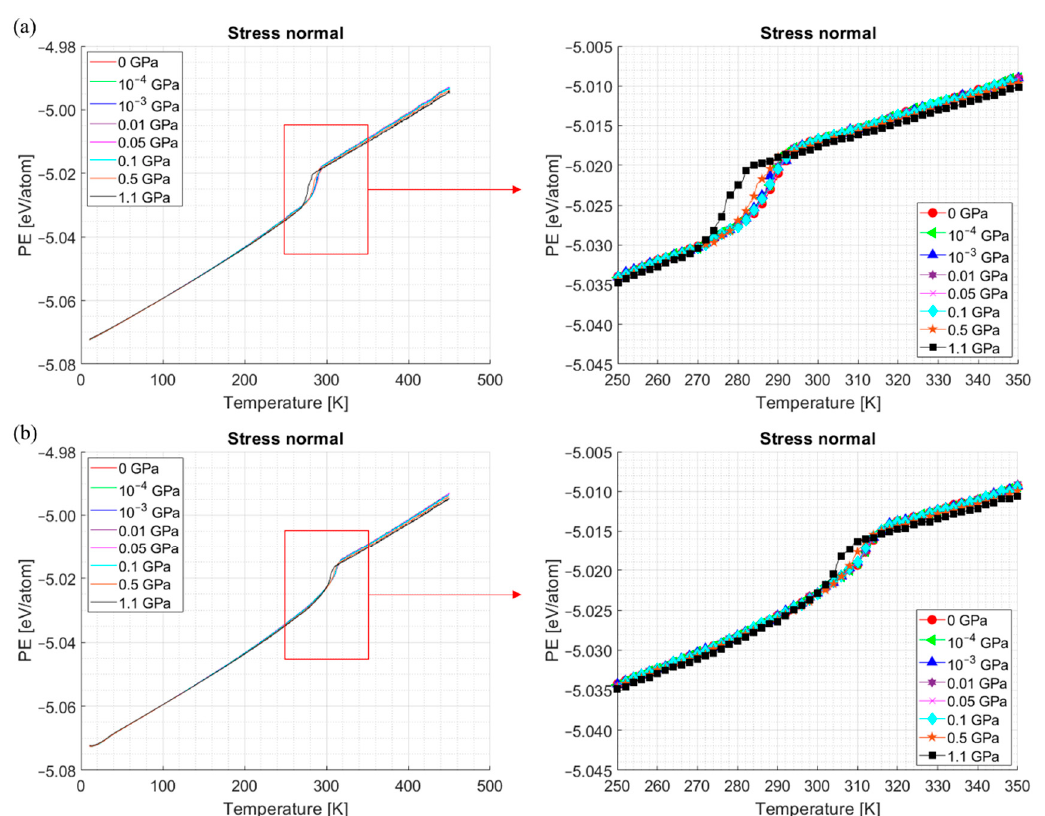
Figure 2. PE profiles during cooling and heating from simulation domain under hydrostatic pressure only: ( a ) cooling, ( b ) heating.